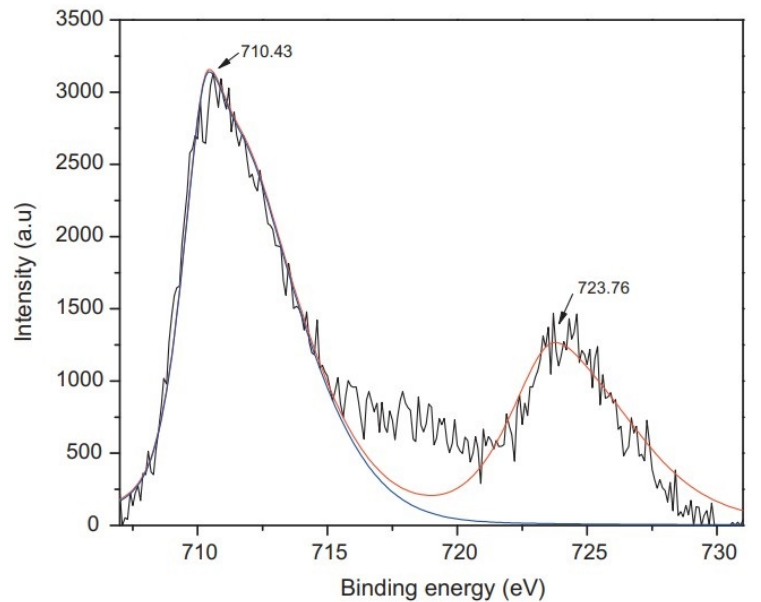
Figure 8. Shirley background-subtracted Fe2p1/2 and Fe2p3/2 XPS spectra of biochar/ γ -Fe 2 O 3 composite [115]. Reprinted with permission from Ming Zhang et al. (2012). Copyright 2012, Elsevier.